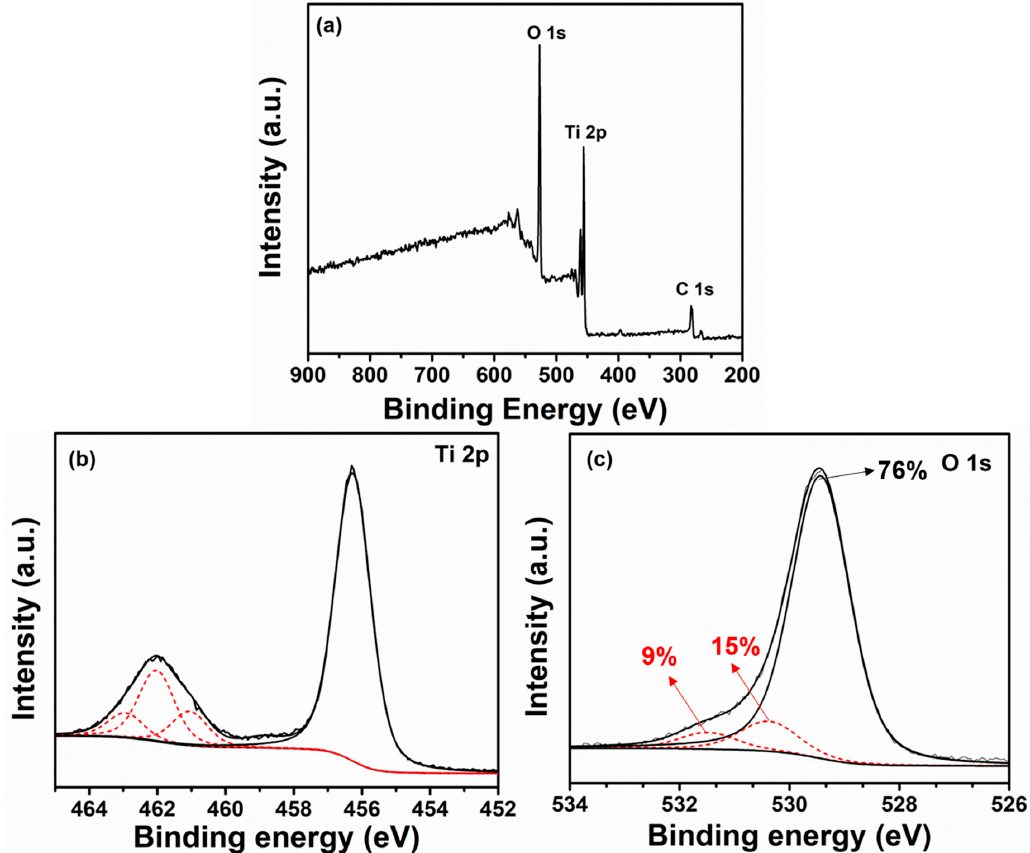
Figure 5. Typical XPS spectra of ( a ) survey, ( b ) deconvoluted high-resolution Ti 2p, and ( c ) deconvoluted high-resolution O 1s plots of as-synthesized TiO 2 nanoflowers.